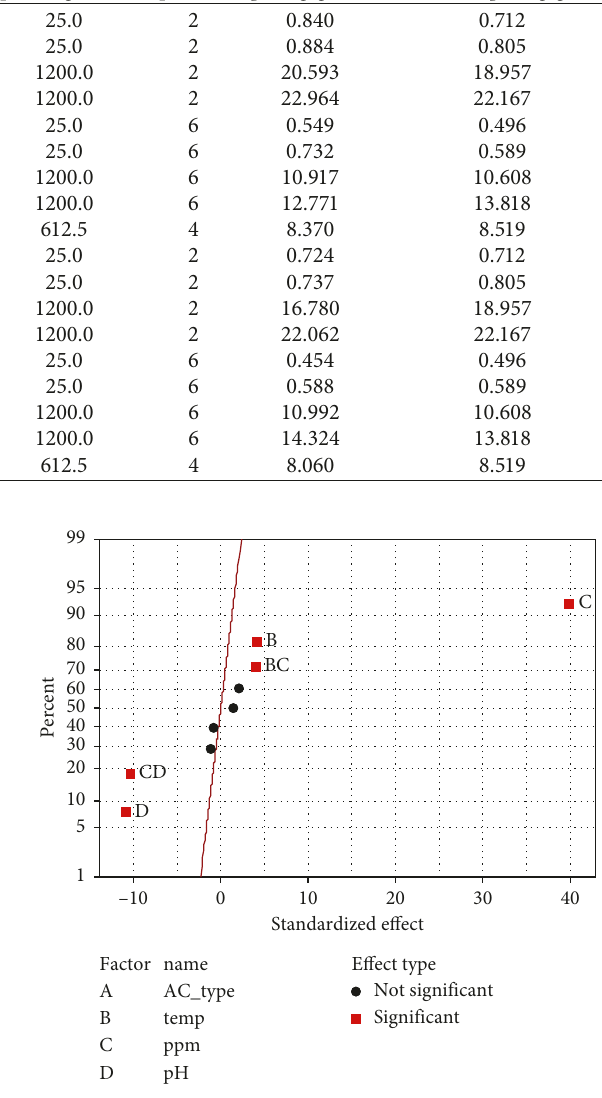
Figure 2: Normal plot of the standardized effects (response is q alpha e . (cid:31)